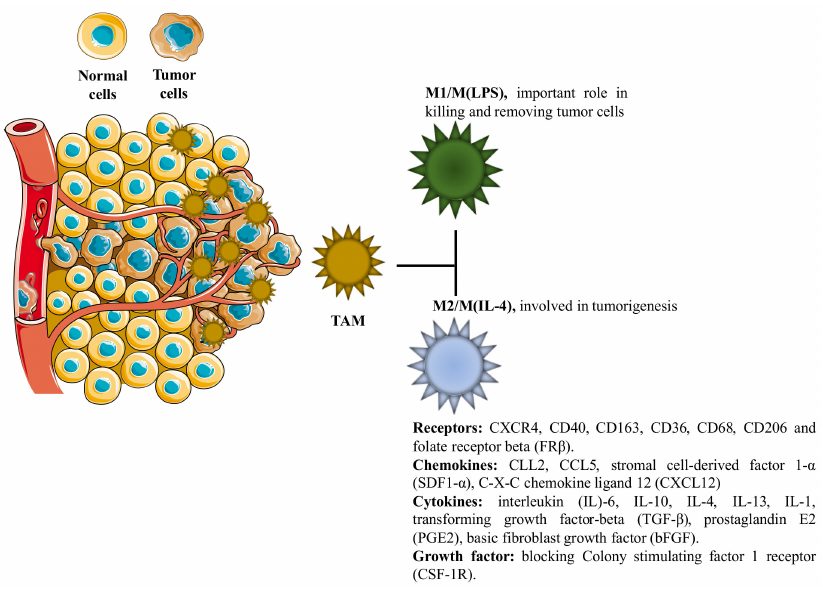
Figure 4. Tumor-associated macrophages (TAMs) in tumor microenvironment: macrophages phenotypic differentiation into either M1 or M2 subtype. M2 is the subtype of TAM involved in tumorigenesis and description of receptors, chemokines, cytokines and growth factor as targeting approaches